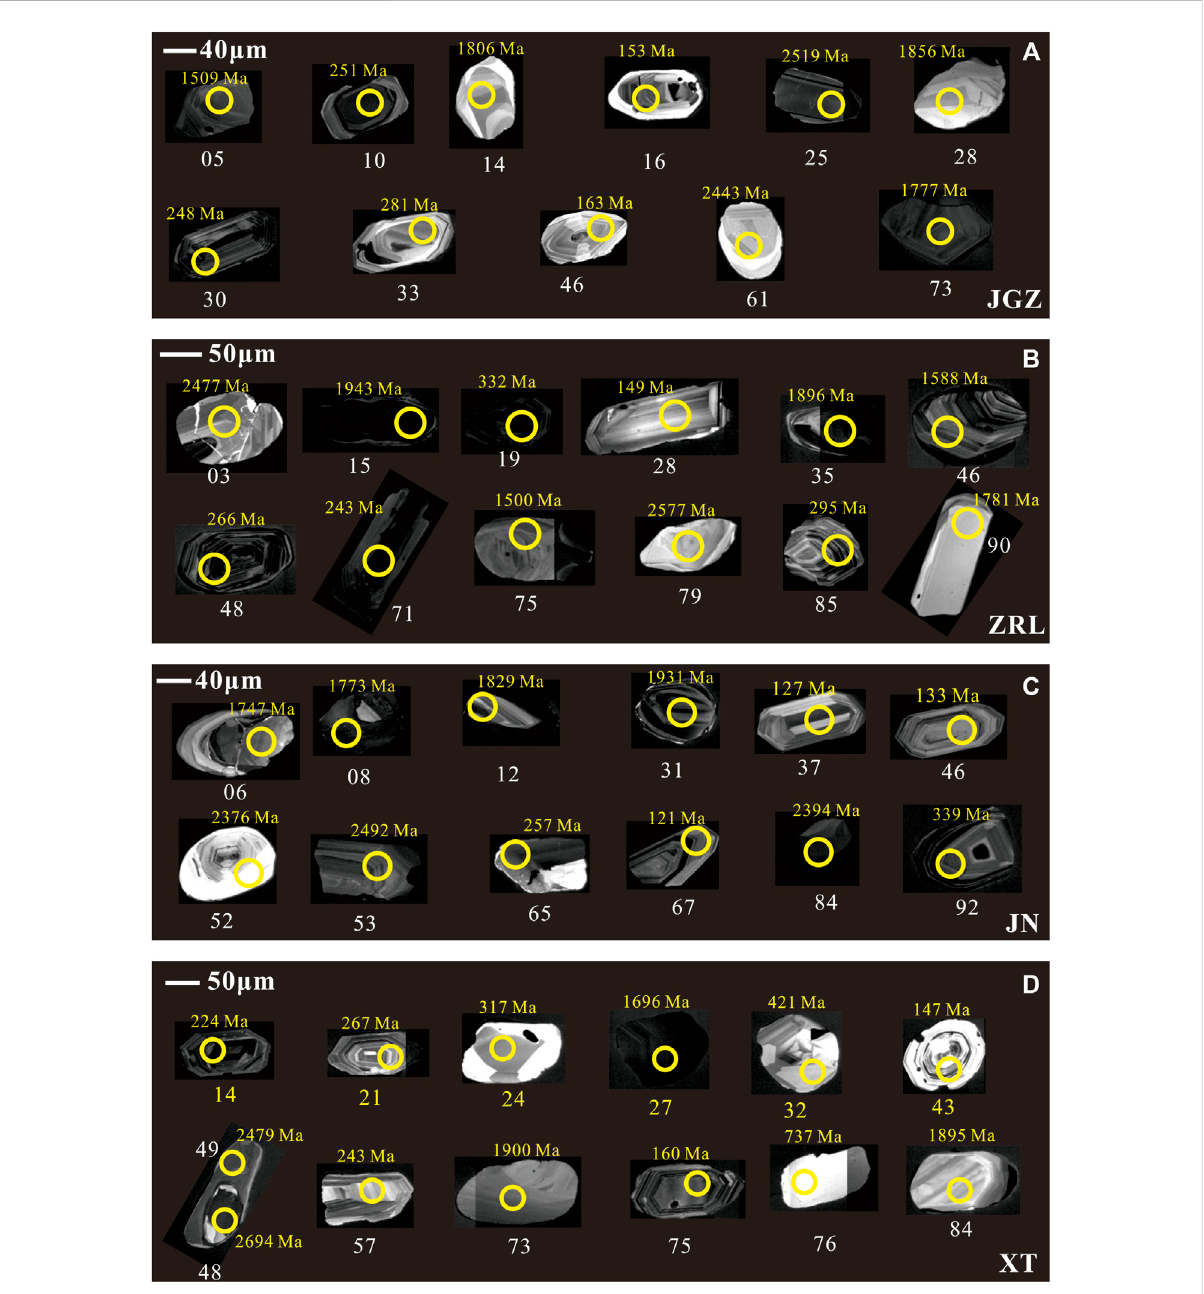
FIGURE 6 Representativecathodeluminescence(CL)imagesofanalyzedzirconsfromthewesternShandongprovinceandTanlufaultzone;yellowcircles showing the positions of LA-ICP-MC laser spots for age isotopic domains; samples (A, B, D) from the western Shandong province, and sample (C) from the Tanlu fault